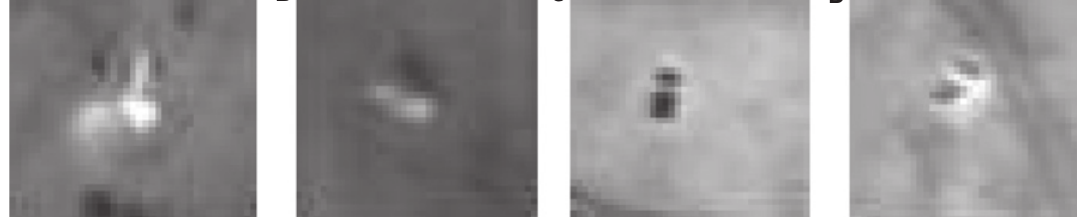
Figure 7: Thermal images of (A, B) tanks (C, D) Truck.